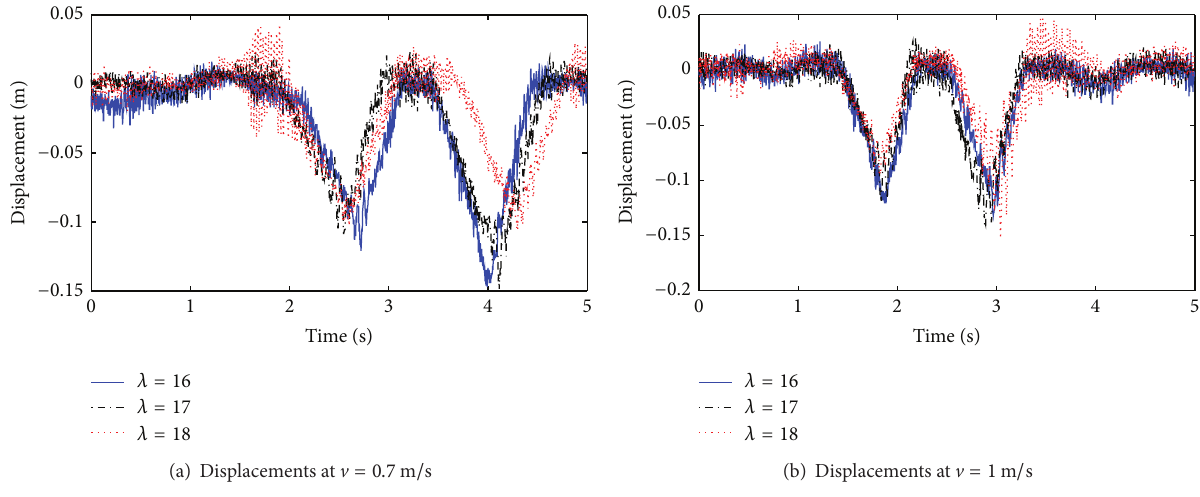
Figure 9: Experimental vibrations at the midpoint of the span for different propagation